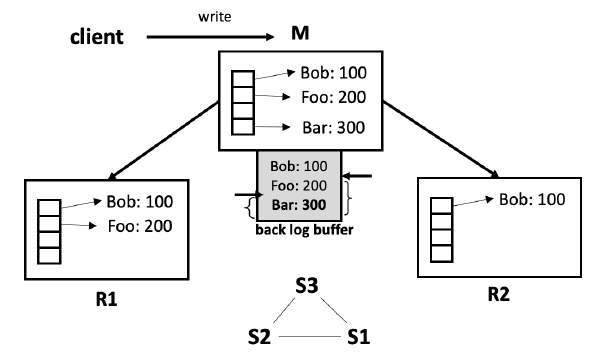
Figure 1. Redis architecture. M, R, and S stand for master, replica, and sentinel,